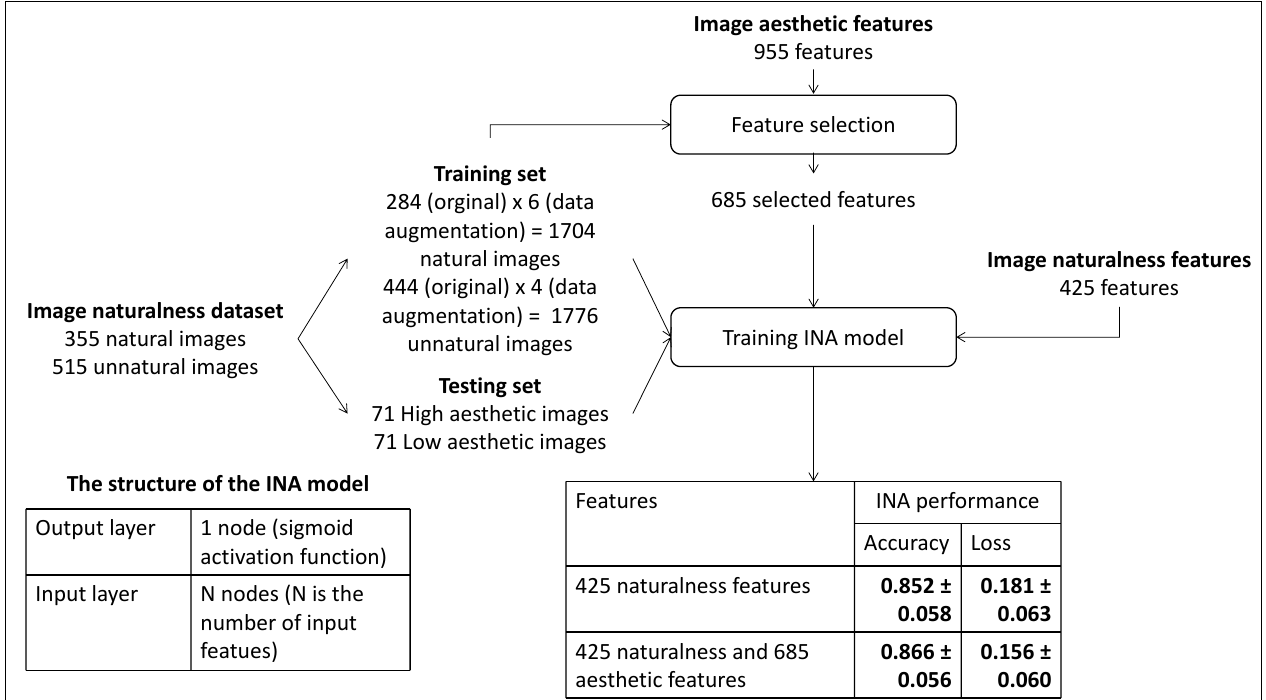
Figure 7. Experiment process of evaluating how IA features improves the performance of